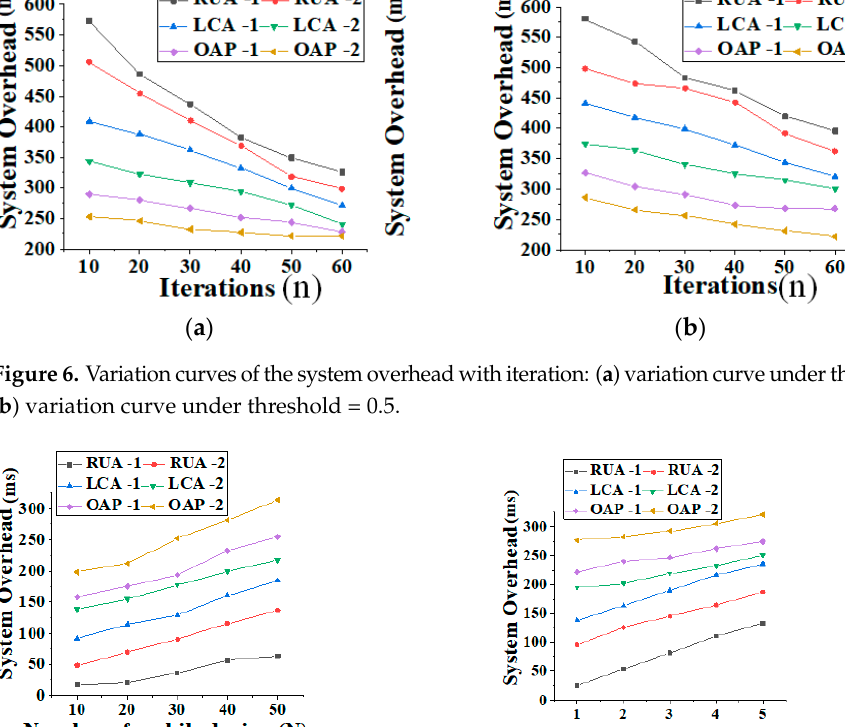
Figure 6. Variation curves of the system overhead with iteration: ( a ) variation curve under thresh- old = 0.1; ( b ) variation curve under threshold = 0.5.